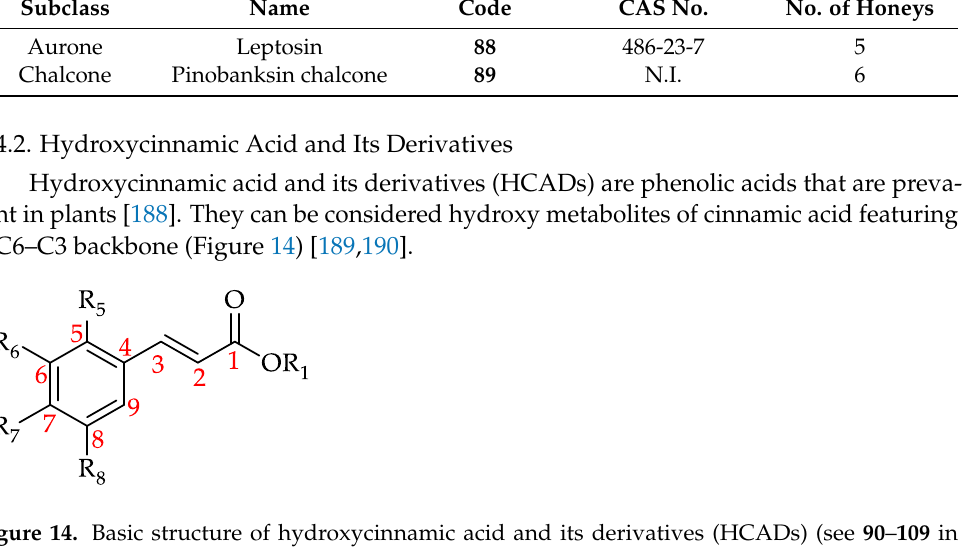
Figure 14. Basic structure of hydroxycinnamic acid and its derivatives (HCADs) (see 90 – 109 in Table 9). Table 9. Hydroxycinnamic acid and its derivatives reported in monofloral honeys (see Figure 14 for general structure).